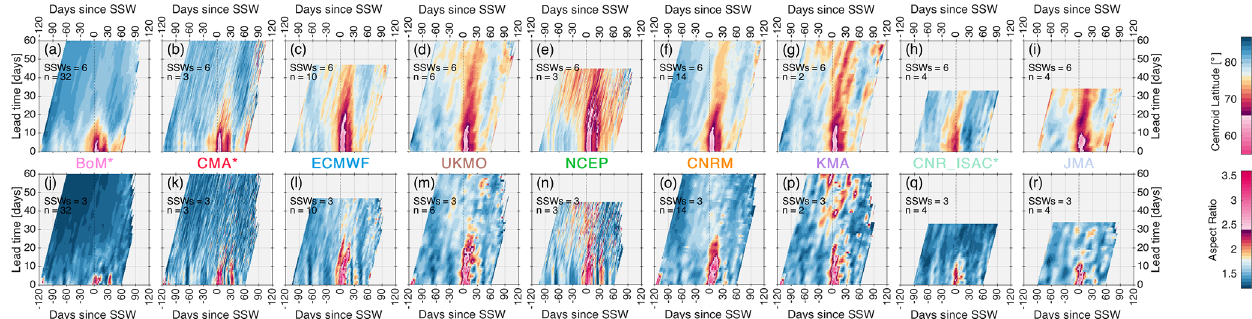
Figure 8. Predictions of the boreal stratospheric vortex (a–i) centroid latitude and (j–r) aspect ratio, computed at 10hPa from hindcast geopotential height. Values shown are an average of all ensemble members over all (a–e, f–i) displacement and (j–n, o–r) split SSWs in the 1999–2020 record. Data are plotted against (horizontal axis) the SSW-relative day number and (vertical axis) model lead time. For each panel, the number of SSWs (“SSWs”) and number of ensemble members (“ n ”) are indicated at top left. The color-bar transitions to pink occur at thresholds of 66 ◦ N for the centroid latitude and 2.4 for the aspect